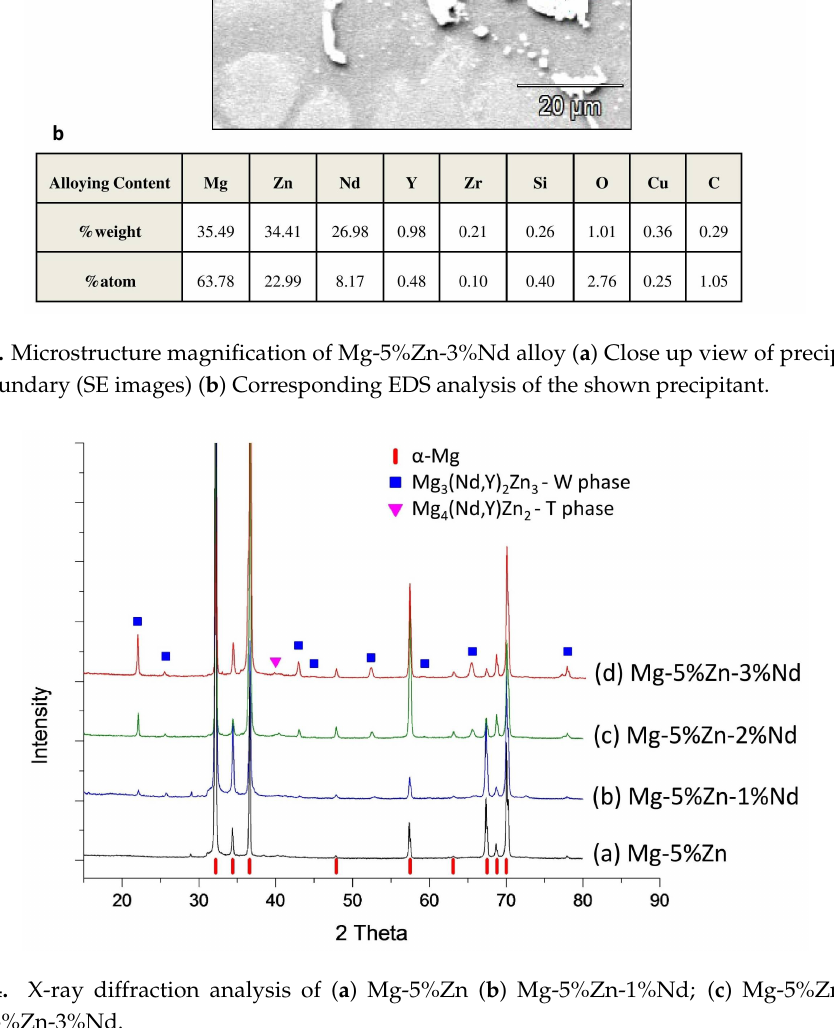
Figure 4. X-ray diffraction analysis of ( a ) Mg-5%Zn ( b ) Mg-5%Zn-1%Nd, ( c ) Mg-5%Zn-2%Nd ( d ) Mg-5%Zn-3%Nd. Table 2. Phase type, lattice parameter of W-phase and volume fraction of secondary phases as related to alloy